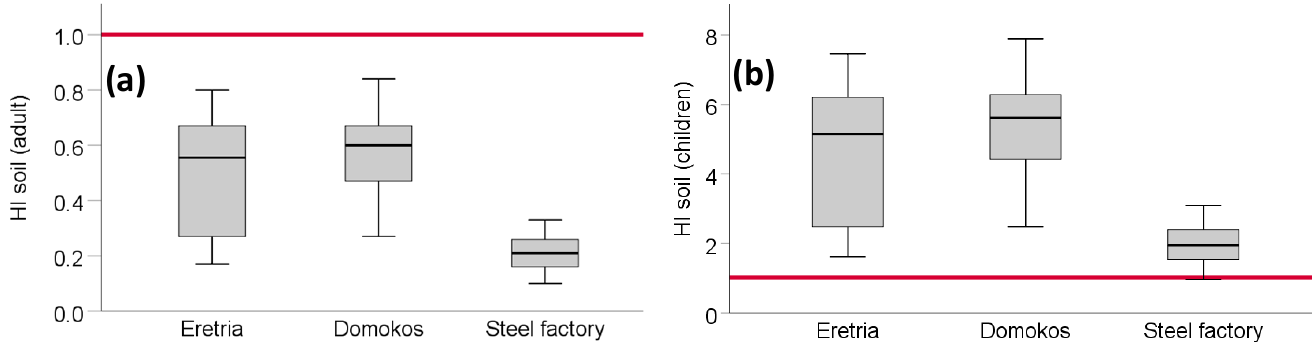
Figure 5. Hazard index (of the soil ingestion pathway) for adults ( a ) and children ( b ).